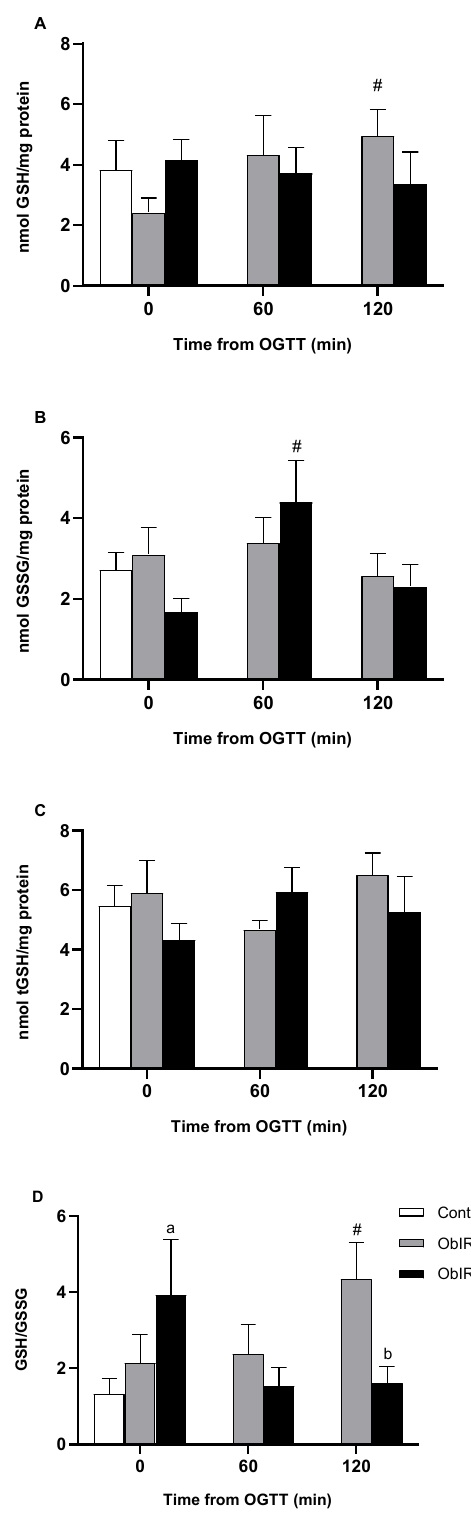
Figure 2. Glutathione availability in RBCs of healthy and obese children. GSH ( A ) and GSSG ( B ) were measured in RBCs at baseline and along OGTT. tGSH ( C ) and GSH/GSSG ( D ) were also calculated. White bars represent the control group, grey bars represent ObIR − group, and black bars represent ObIR+ group. Values are means ± SEM. p < 0.05 was considered for statistical significance. (a) shows significant differences relative to control at baseline, (b) shows significant differences relative to ObIR − , and ( # ) shows intragroup differences along the OGTT.